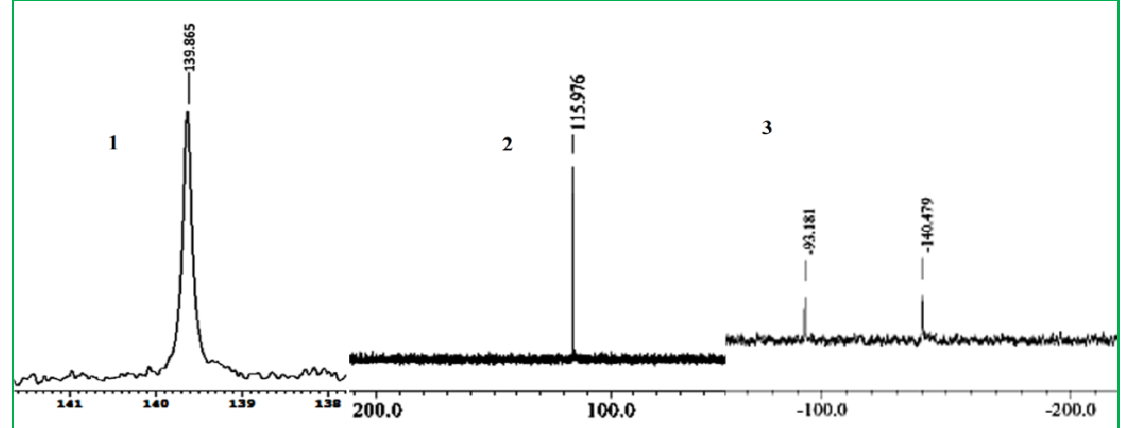
Figure 3. 119 Sn NMR spectra of the complexes 1, 2 and 3 .